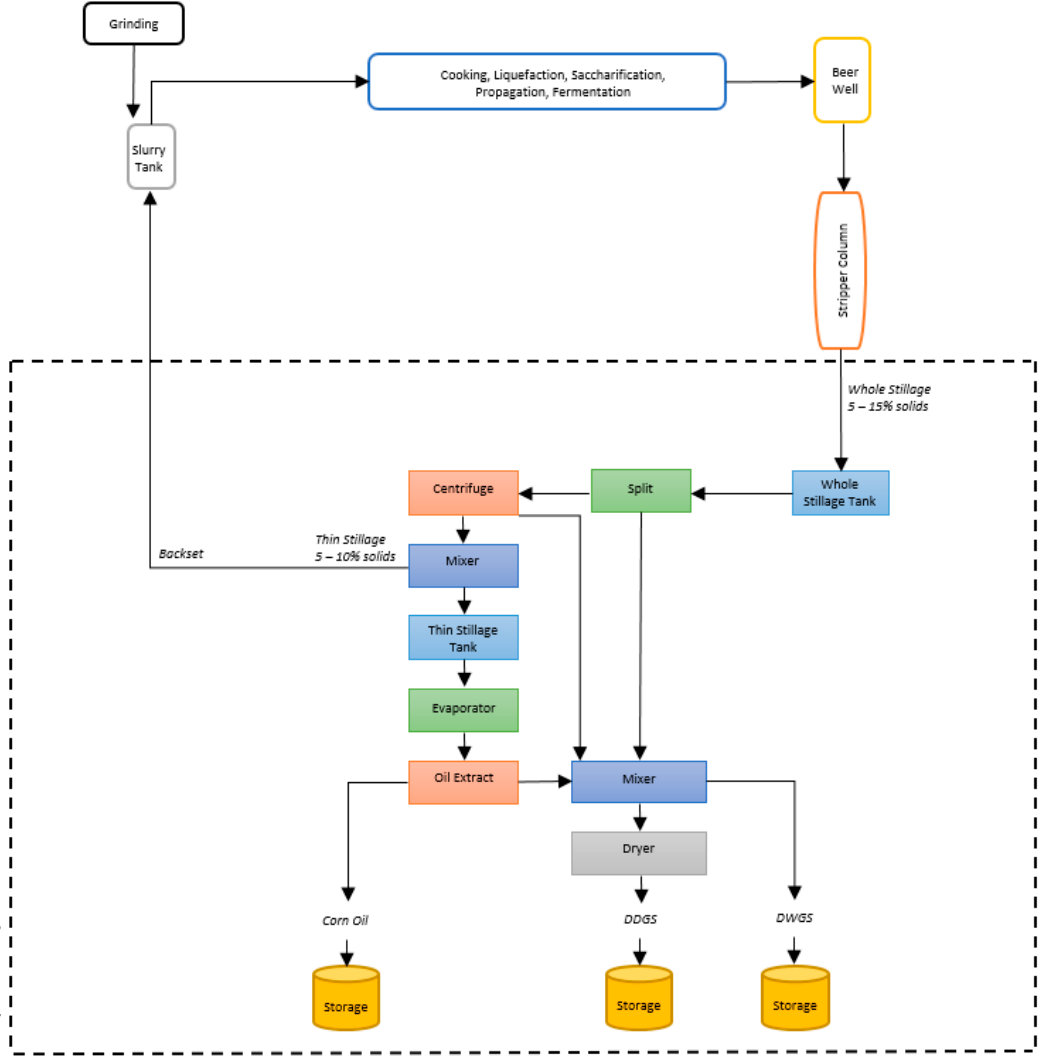
Figure 1. Simplified flow diagram of a conventional corn-based ethanol plant flow chart (Scenario I). The system boundary includes tanks, splitter, centrifuge, mixers, dryer, evaporator, and storage systems.